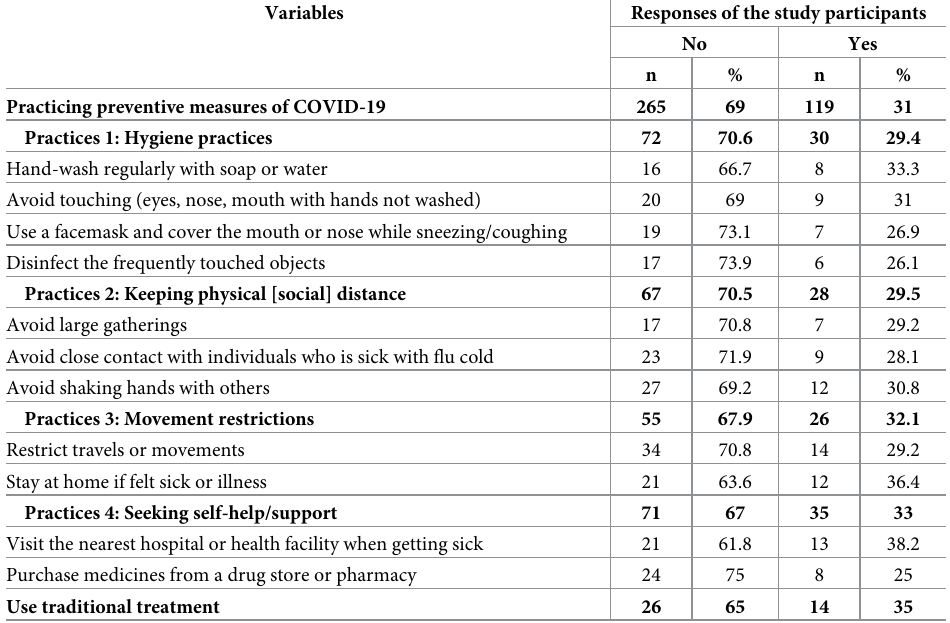
Table 3. Indicators and responses to practices of preventive measures, OSZSF, 2020 (n = 384).